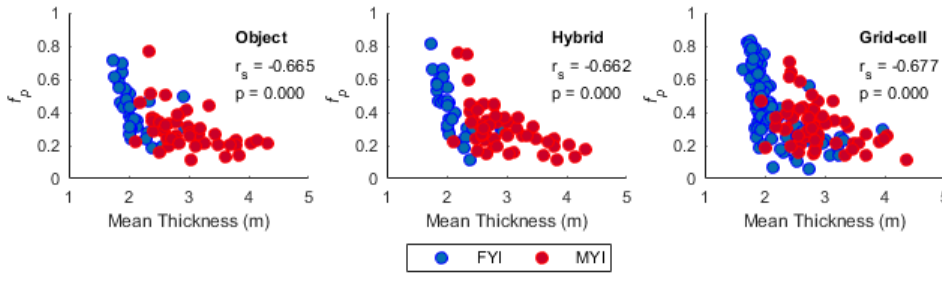
Figure 7. Scatter plots of f p as a function of mean thickness at the medium scale using object ( left ), hybrid object ( middle ) and 240 m grid-cell ( right ) aggregation approaches. Spearman correlation coefficients (r s ) and corresponding p -values are shown for pooled FYI and MYI data.